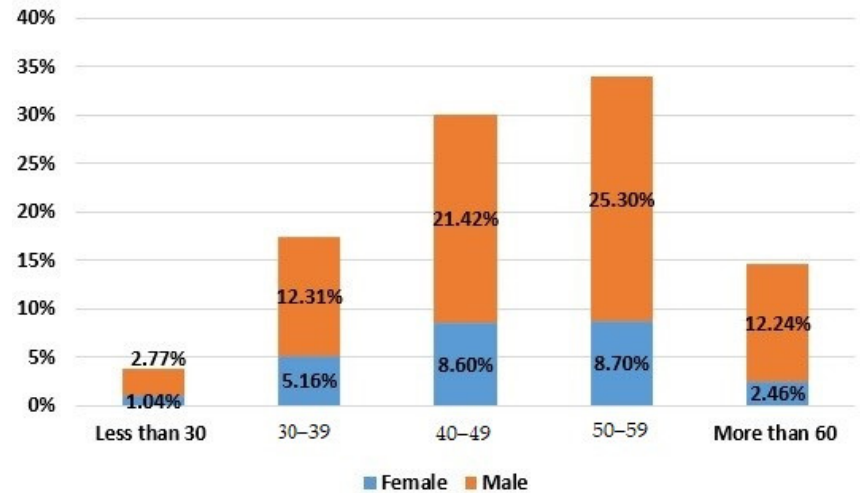
Figure 1. Distribution of the teaching and research staff of the Universitat Politècnica de Catalunya by age and gender.